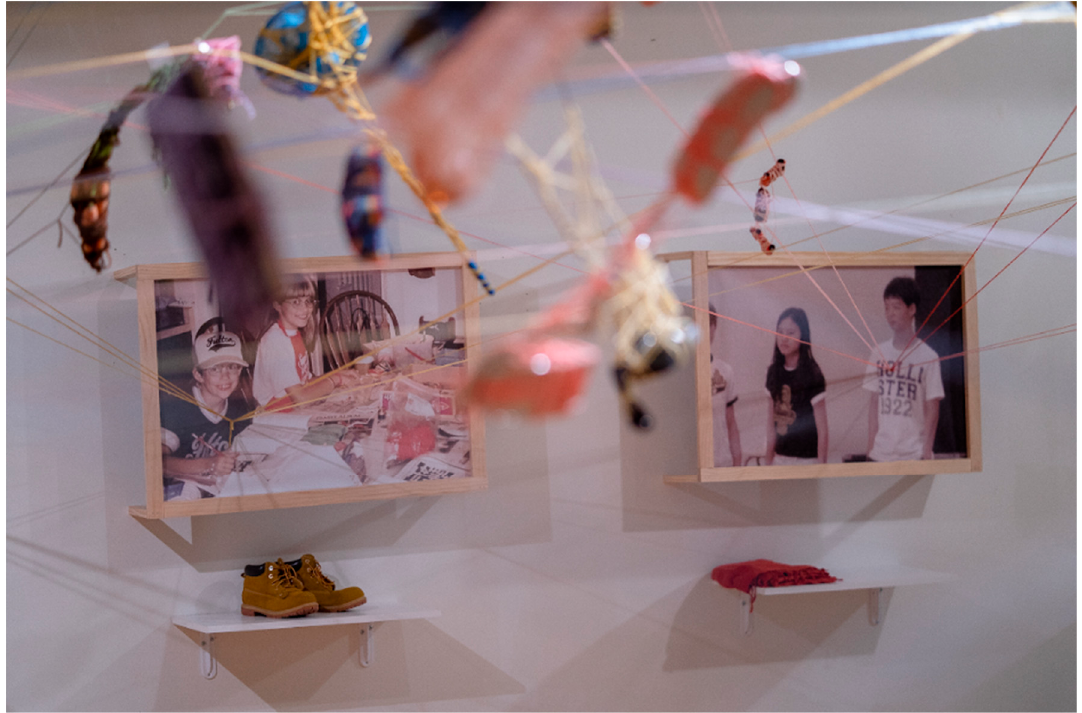
Figure 7. Detail photo of thread connecting to portraits in Becoming Us , 2018 (Photo graciously provided by Megan Altieri).